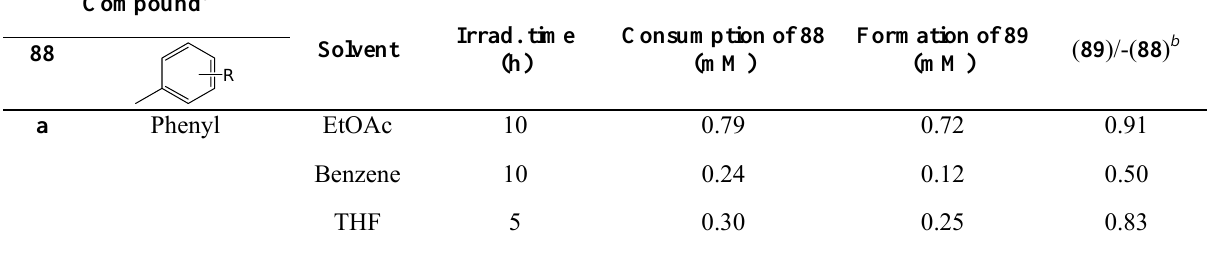
Table 10. Photocyclization of 2'-hydroxychalcones with visible light. Compound